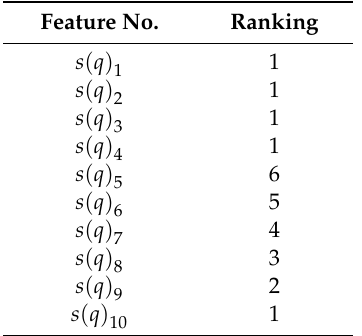
Table 1. Feature ranking obtained by